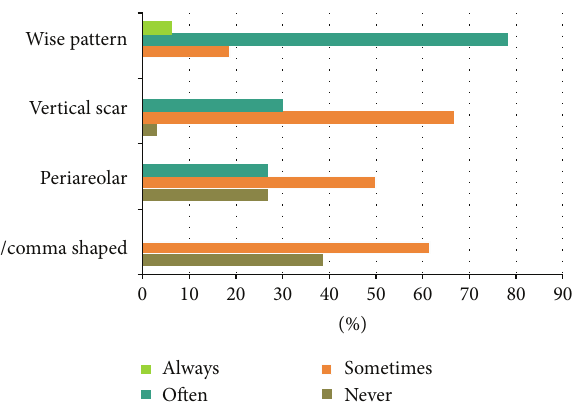
Figure 1: How often do you use the following skin resection techniques in your practice?